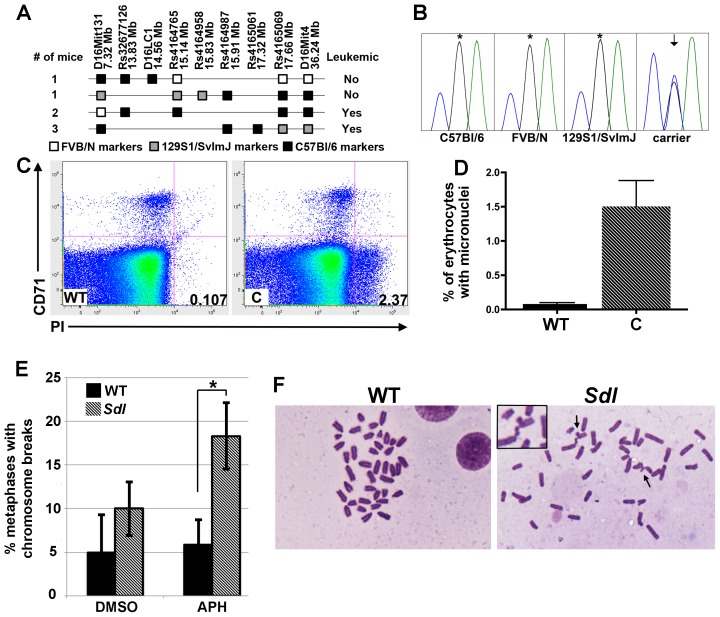

Sdl mice harbor a mutation in Mcm4 that causes chromosomal abnormalities.A) Recombination events in Chr 16 that define the Sdl interval. Only the relevant Sdl haplotype is shown. White squares: FVB/N alleles, Grey squares: 129S1/SvImJ alleles, Black squares: C57Bl/6 alleles. The Sdl mutation must map within regions harboring C57Bl/6 alleles in leukemic mice, but must be excluded from regions harboring C57Bl/6 alleles in non-leukemic mice. Analyzing two non-leukemic mice indicates that the Sdl mutation likely lies distal to 14.56 and proximal to 15.91. The two non-leukemic mice were bred and non-carrier status was verified. B) Sanger sequencing traces demonstrating the G to C substitution present in all confirmed Sdl carriers but absent from all wild-type strains examined. Arrow indicates dual G/C peak, asterisk indicates wild-type G peak. C) Sdl mice harbor increased numbers of spontaneous micronuclei. Example flow cytometry plots for wild-type (WT) and Sdl carrier (C) mice for micronuclei detection. Micronucleated normochromatic erythrocytes are propidium iodide (PI) positive but CD71 negative (lower right quadrant) and are expressed as a percentage of total erythrocytes. D) Quantification of micronuclei for sex and aged-matched wild-type (solid bar, WT) (n = 8) and Sdl carriers (striped bar, C) (n = 5). Mean for wild-type = 0.0815 and for Sdl carriers = 1.503 (p<0.0005). Error bars represent standard deviation. E) Sdl (striped bars) and wild-type (solid bars) MEFs were treated with Dimethyl sulfoxide (DMSO) as vehicle control or 0.15 µM aphidicolin (APH) and the percent of metaphases with chromosome breaks determined. No statistically significant difference between Sdl and wild-type was observed when cells were treated with vehicle only (p>0.26, t-test). In the presence of APH, Sdl MEFs did harbor more chromosome breaks (average 18.3%) than wild-type MEFs (average 5.8%) (p<.02, t-test, asterisk). Error bars represent standard deviation. F) Example metaphase spreads without chromosome breaks (WT, APH treated) and with chromosome breaks (Sdl, APH treated). Arrows indicate chromosome breaks, one example shown as inset.